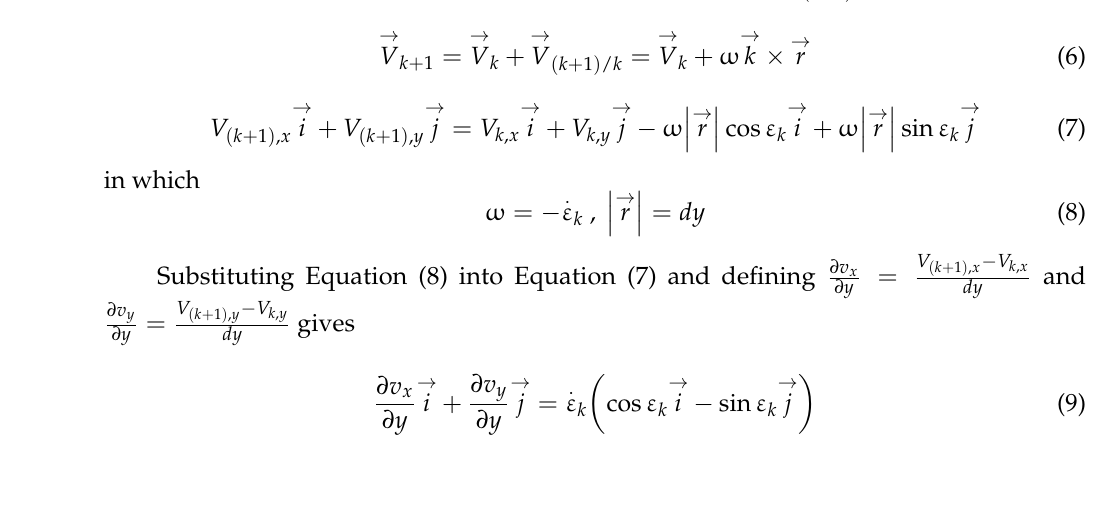
Figure 10. ( a ) The definition of the horizontal and vertical velocities; ( b ) rotation, angular velocity and relative velocity in the connecting element as a rigid body; ( c ) convention of axes and unit vectors; and ( d ) convention of horizontal and vertical velocity vectors and angular velocity.